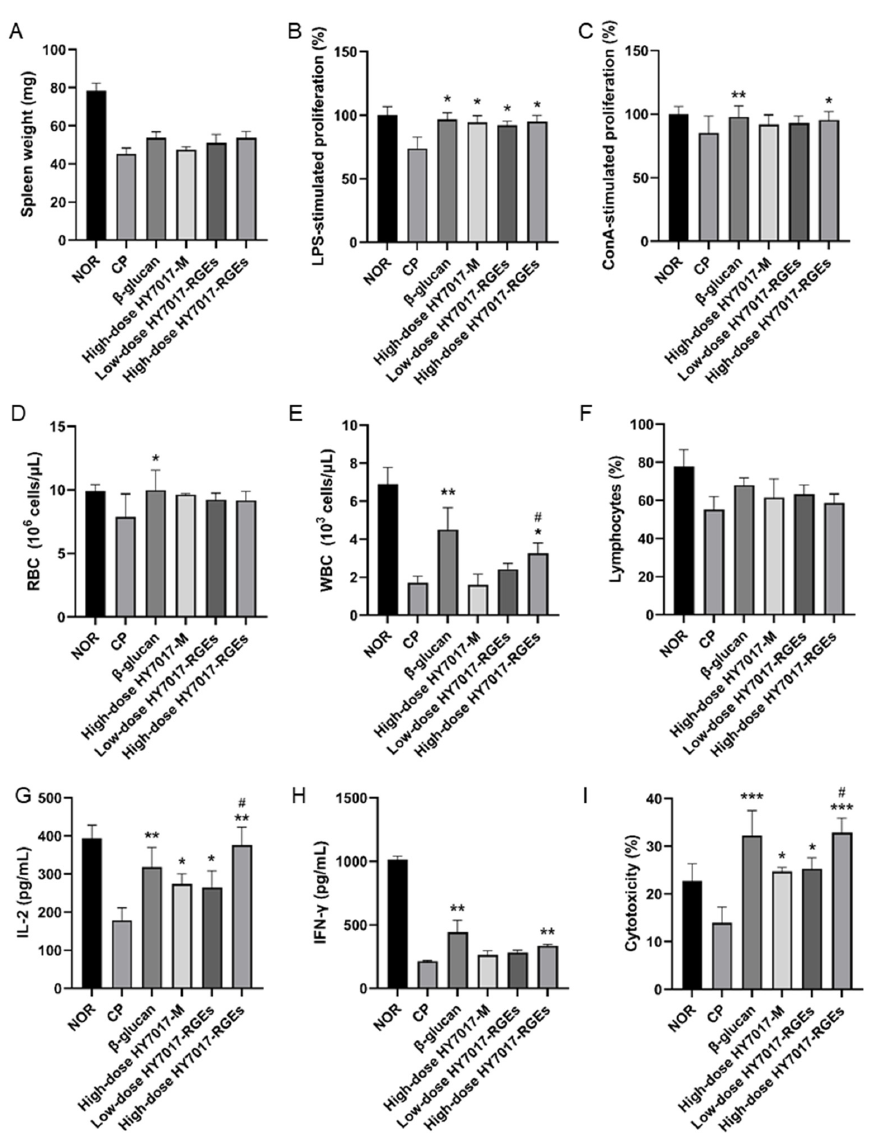
Figure 4. Effect of orally administered Lactobacillus paracasei HY7017 in CP-immunosuppressed mice on the weight of spleen ( A ), lipopolysaccharide-induced B-cell proliferation ( B ), and concanavalin A-induced T-cell proliferation lipopoly- saccharide-induced B-cell proliferation ( C ) in splenocytes. The number of red blood cells (RBC, ×10 6 /µL) ( D ) and white blood cells (WBC, ×10 3 /µL) ( E ); ratio of lymphocytes ( F ); level of IL-2 ( G ) and IFN- γ cytokines ( H ) secreted from ConA- treated splenic cytotoxic T-cells; splenic NK cell activity ( I ). Data are represented as the mean ± standard error of the mean (SEM) ( n = 7 mice per group). * p < 0.05, ** p < 0.01 and *** p < 0.001 compared with CP. # p < 0.05 compared with High- dose HY7017-M. NOR, normal mice; CP, treated with CP; β -glucan, oral administration with 20 mg/kg of β -glucan for 5 days after CP-induction; high-dose HY7017-M, oral administration with 1×10 9 CFU/mL of HY7017 grown in MRS for 5 days after CP-induction; low-dose HY7017-RGEs, oral administration with 1×10 8 CFU/mL of HY7017 grown in 3%RGE- supplemented MRS for 5 days after CP-induction; High-dose HY7017-RGEs, oral administration with 1×10 9 CFU/mL of HY7017 grown in 3% RGE-supplemented MRS for 5 days after CP induction. We measured the effect of HY7017 on the proliferative capacity of splenocytes from CP-immunosuppressed mice stimulated with LPS and ConA (Figure 4B,C). CP treatment significantly reduced the proliferative response of lymphocytes to LPS and ConA to 86.4% and 85.1% of the normal group, respectively, at day 5 in CP-treated mice. Oral